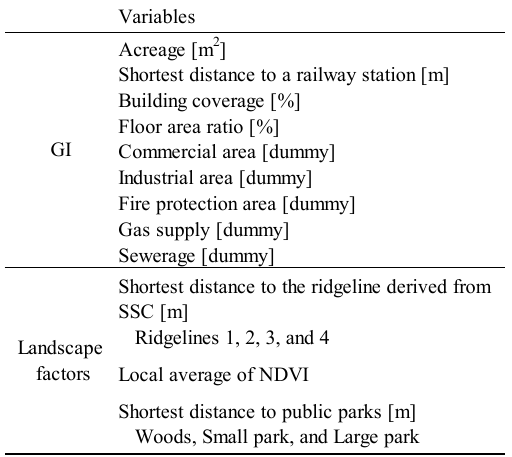
Table 1. Variables we applied to GWR